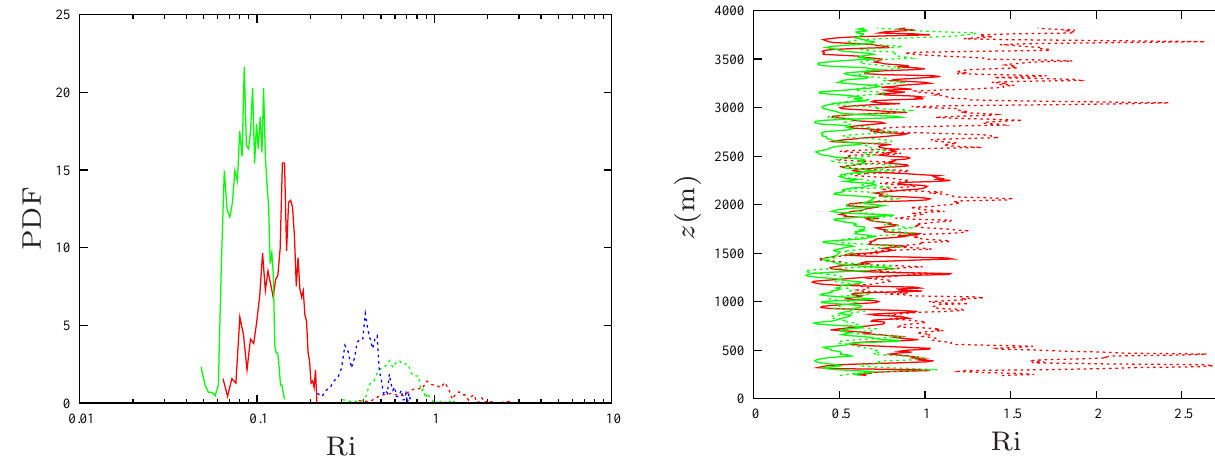
Figure 10. Effect of filtering on vertical distribution of Ri for the weak forcing cases (red lines) and moderate forcing cases (green lines). Solid lines: 1 = 2m data filtered over 1 = 10m support; dotted lines: 1 =